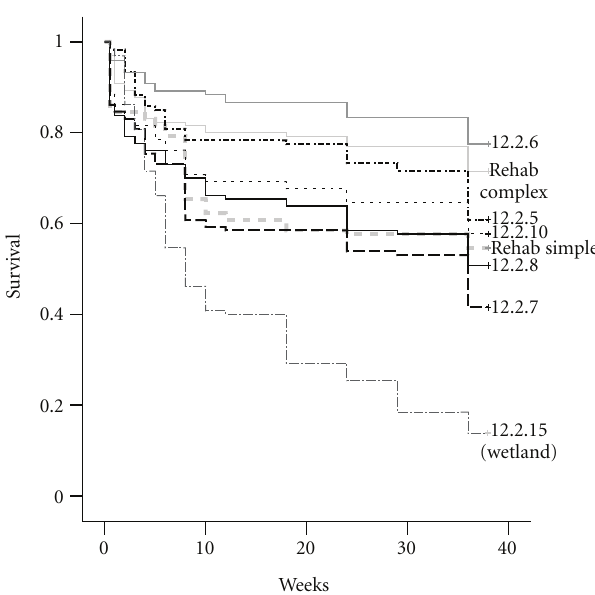
Figure 2: Kaplan-Meier survival curves of scats, displayed by veg- etation community. NB: vegetation communities (12.2.10: mallee Eucalyptus spp. low woodland, 12.2.15: wetlands, 12.2.5: Corymbia spp. open to low closed forest, 12.2.6: E. racemosa woodland, 12.2.7: Melaleuca quinquenervia open forest to woodland, and 12.2.8: E. pilularis open forest) follow Queensland Herbarium [27] except for the addition of simple and complex